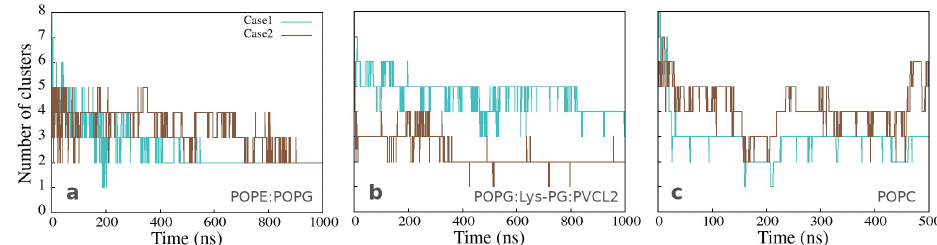
Figure 4. Number of clusters as a function of simulation time for simulations of twelve peptides with ( a ) Gram-negative, ( b ) Gram-positive, and ( c ) neutral membranes. The calculation was done with the clustsize Gromacs utility, with the condition that a peptide belongs to a specific cluster if the distance between its atom and any atom in the cluster is less than 0.35 nm. Other clusters properties such as maximum cluster size, cluster size distribution, and representative cluster snapshots are provided in Section C of the Supplementary Materials.